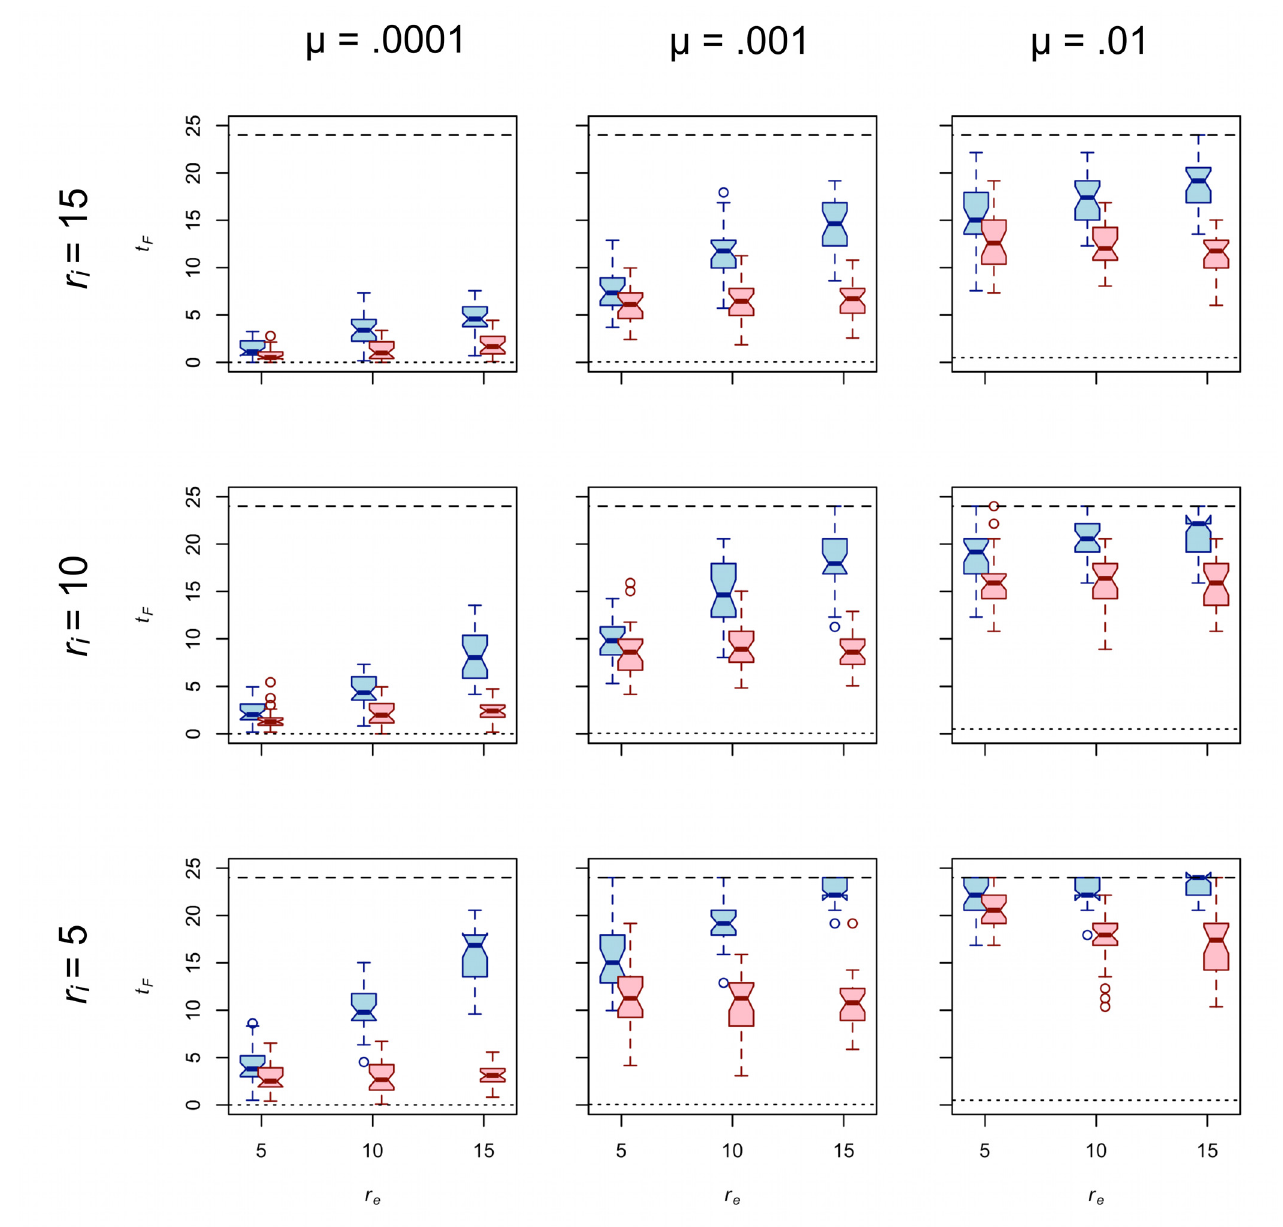
Fig 6. The effect of r e on the diversity of trait A (blue) and trait B (red) for d = 1. Each boxplot represents 30 unique simulation runs. Interaction radius increases from the bottom row to the top row. Copy error rate increases from the left column to the right column. The dotted line in each panel provides the expected value of t F in an idealized Wright-Fisher population. The dashed line in each panel provides the expected value of t F under extreme uniparental cultural